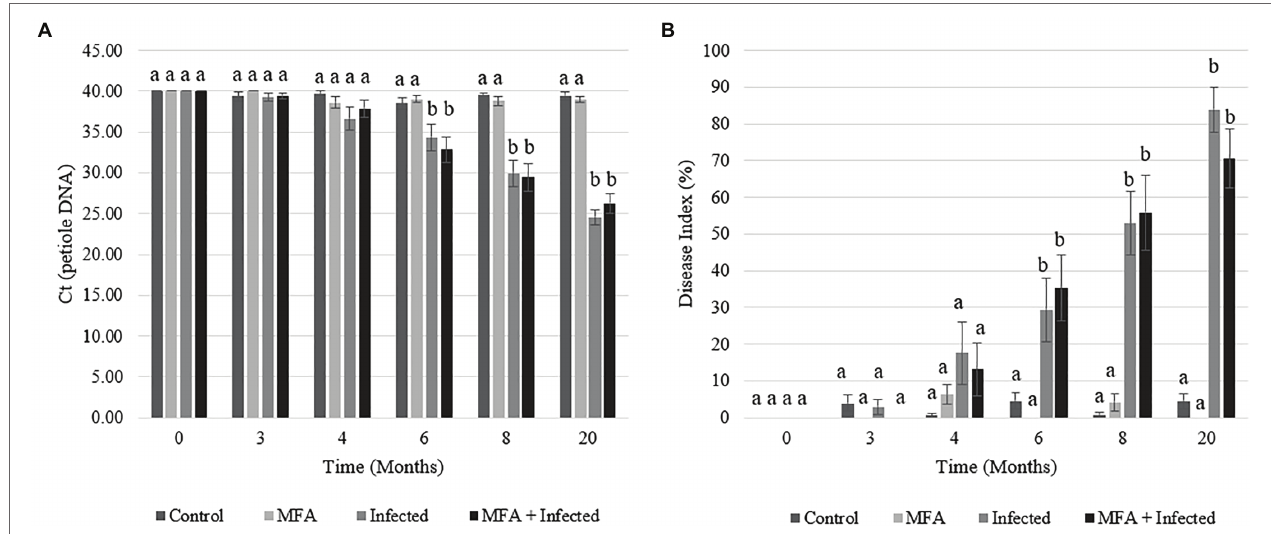
FIGURE 1 | Huanglongbing (HLB) prevalence and disease progression in Citrus sinensis over the duration of the field investigation. (A) HLB infection as C t of petiole DNA measurements was made in infected and uninfected citrus tissue for the duration of the trial. (B) Disease index over time. Data represent average disease index rating over time in each experimental group. Letters that are the same within each time point indicate no differences between groups. Error bars represent ± SEM.